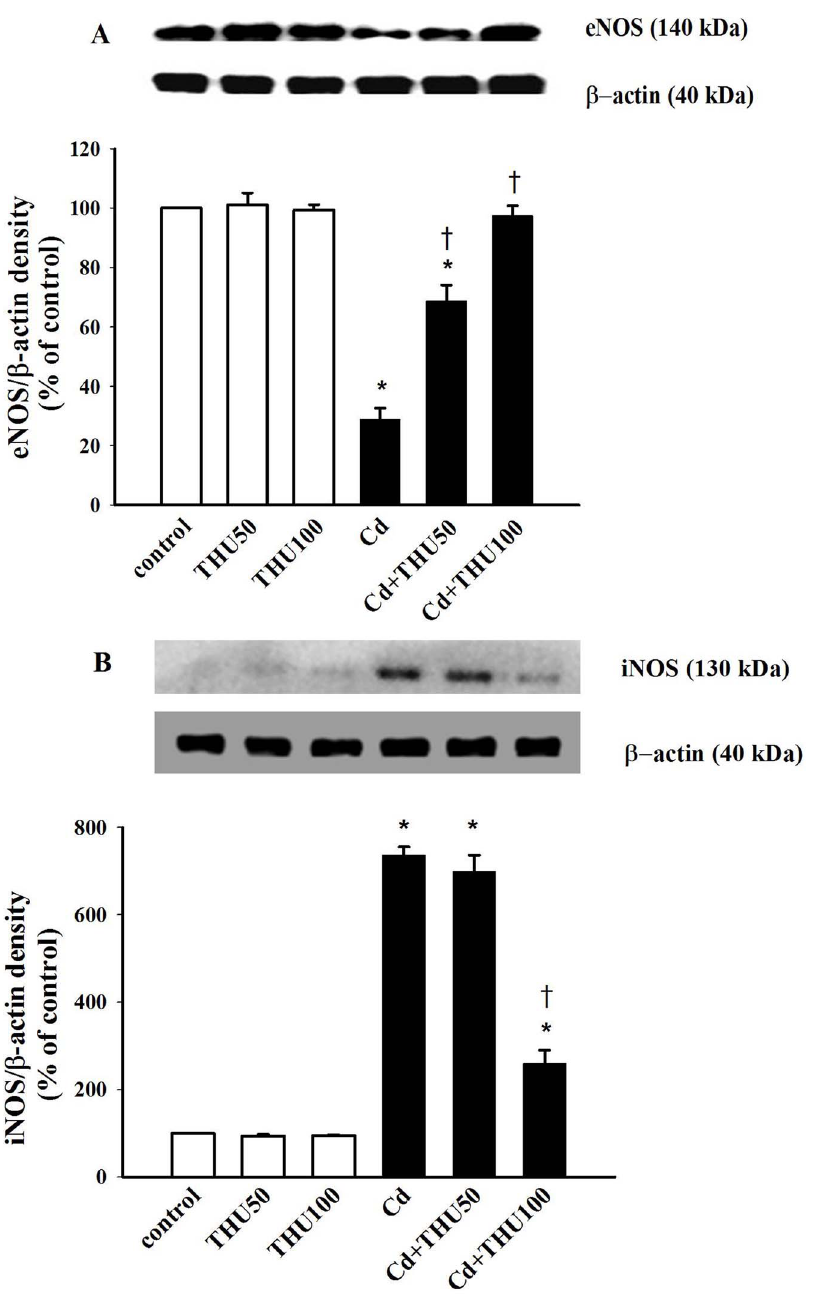
Fig. 2. Effect of THU on eNOS (A) and iNOS (B) protein expressions in the aortas of mice in all experimental groups. Plots show the densitometric intensities of eNOS and iNOS protein expressions for each condition, normalized against b -actin expression and presented as percentage of untreated control values. Results are expressed as mean ¡ SEM., n 5 5–6/group. * P , 0.001 compared with normal control group; { P , 0.001 compared with Cd control